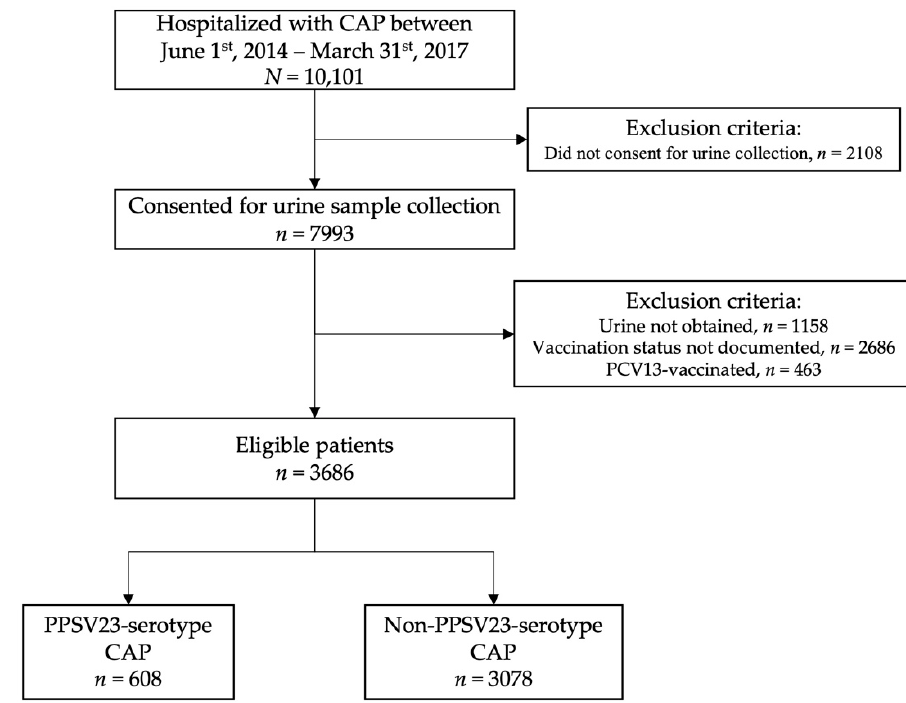
Figure 1. Patient Selection Flowchart.